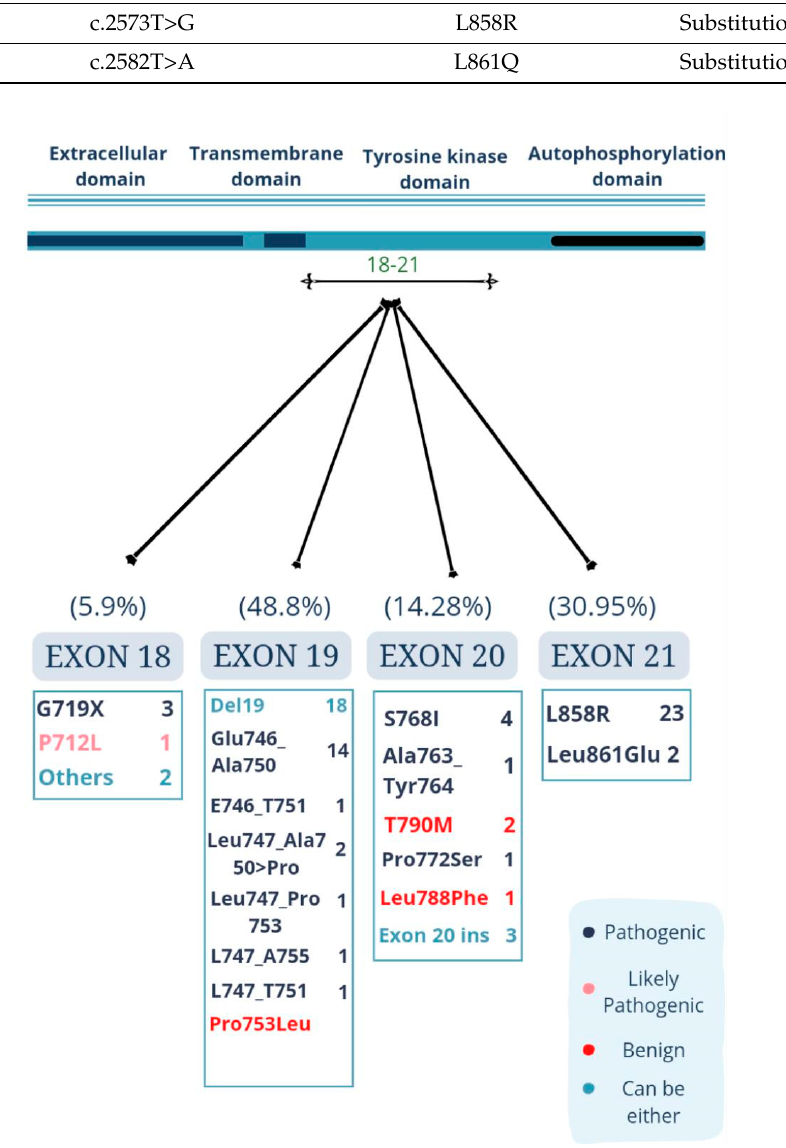
Figure 3. Pathogenicity highlights for EGFR mutations and categories.